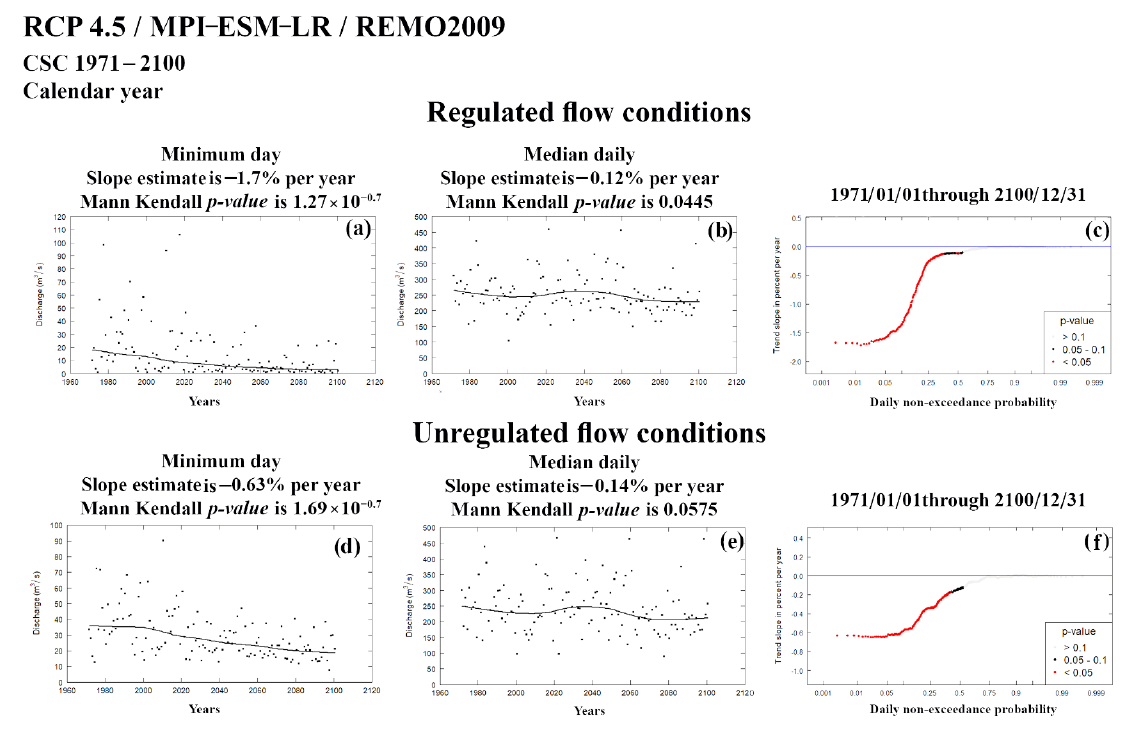
Figure 5. FlowTrend plots from the combination RCP 4.5/MPI − ESM − LR/REMO2009 for annual simulated daily stream- flow for regulated conditions: ( a ) minimum day; ( b ) median day; ( c ) Quantile − Kendall plot, and for unregulated conditions: ( d ) minimum day; ( e ) median day; ( f ) Quantile − Kendall plot. Red color indicates a trend that is significant at alpha = 0.05. Black indicates an attained significance between 0.05 and 0.1. Grey dots are trends that are not significant at the alpha level of 0.1.